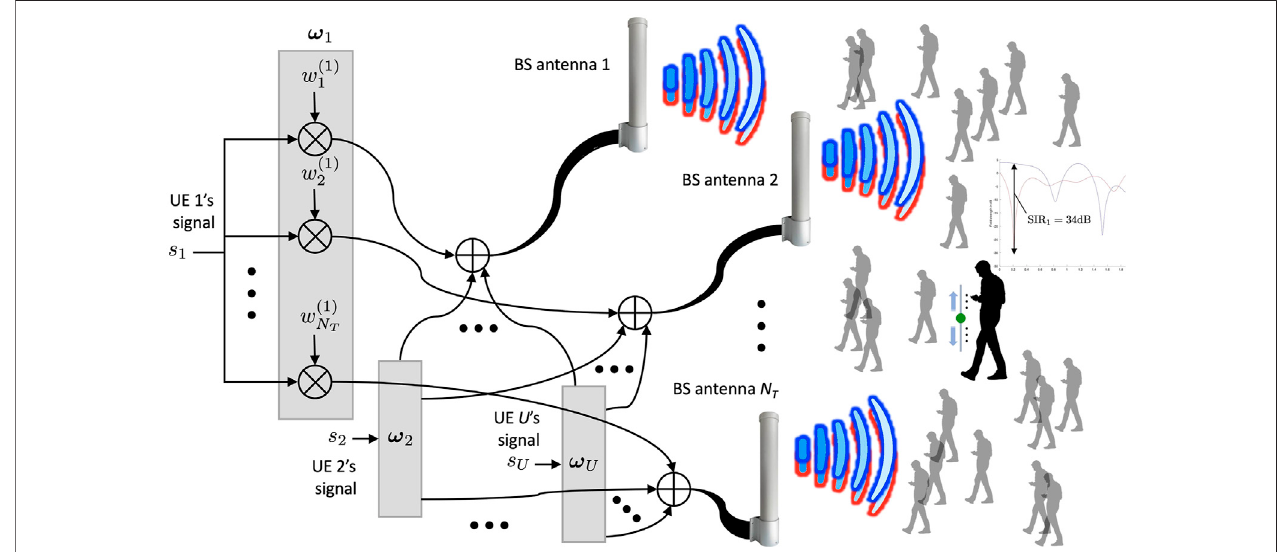
FIGURE 9 | Overloading multiple-input multiple-output with FAMA ( U > N T ) for massive connectivity in the downlink.